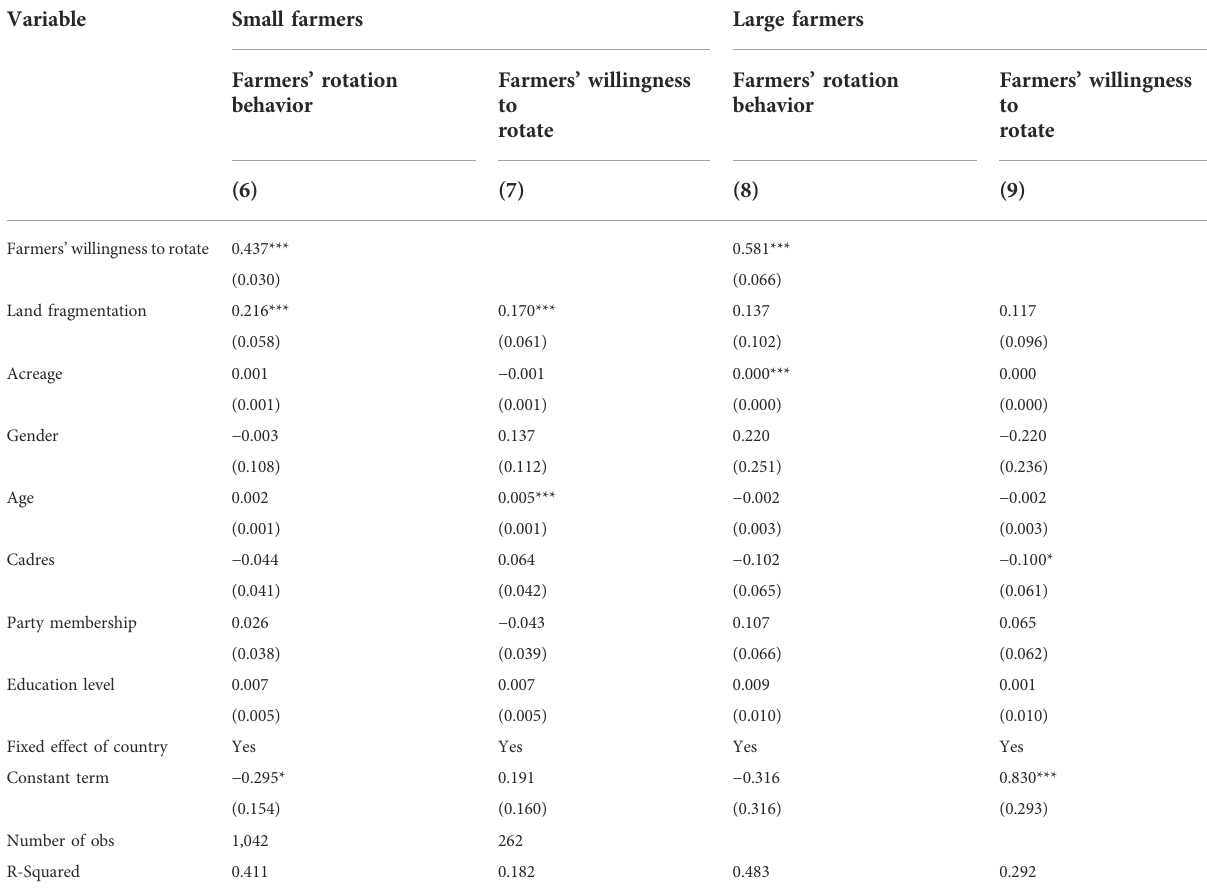
TABLE 5 Heterogeneity analysis of small and large farmers.